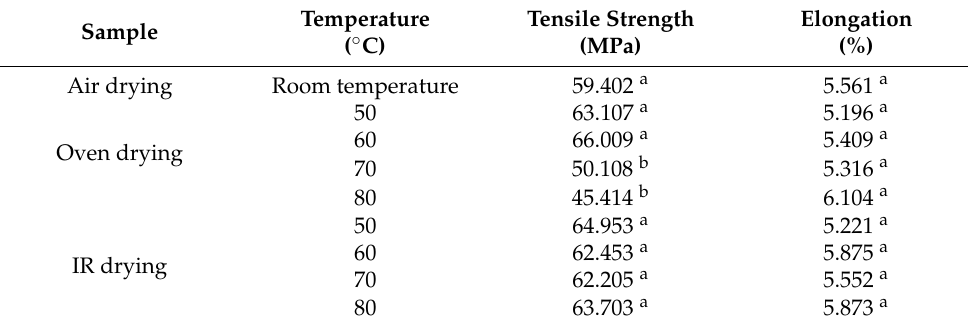
Table 5. Tensile strength and elongation for dried